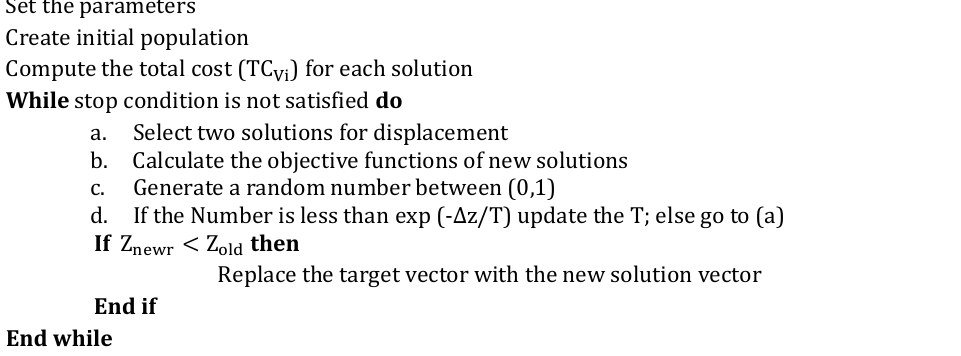
Pseudo code of SA algorithm